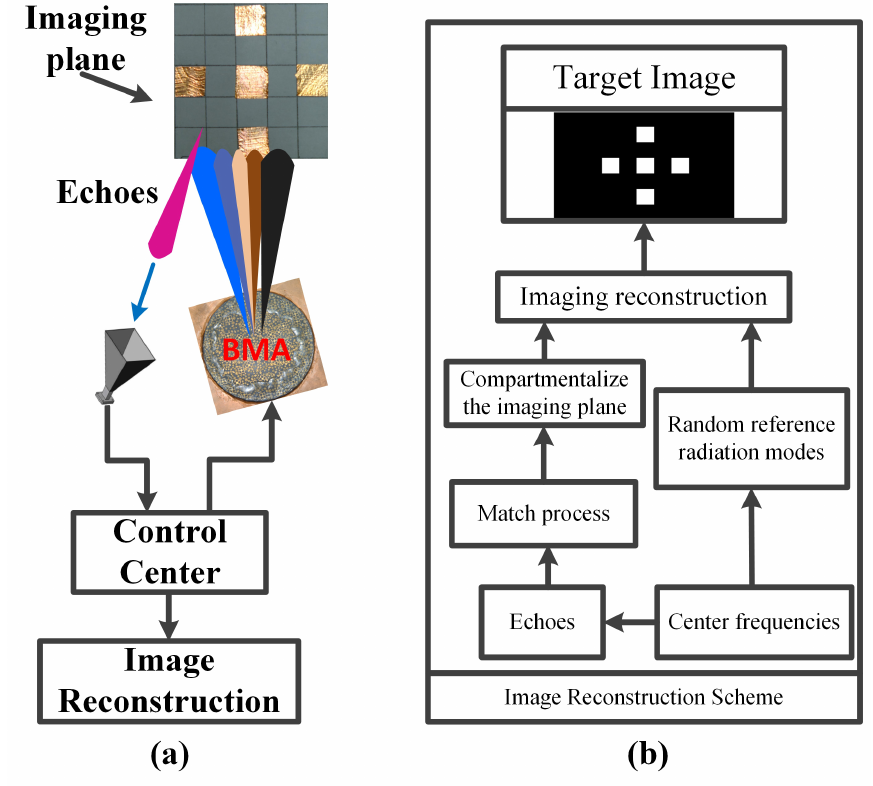
Figure 7. ( a ) Schematic of the coincidence imaging; ( b ) flowchart of the coincidence